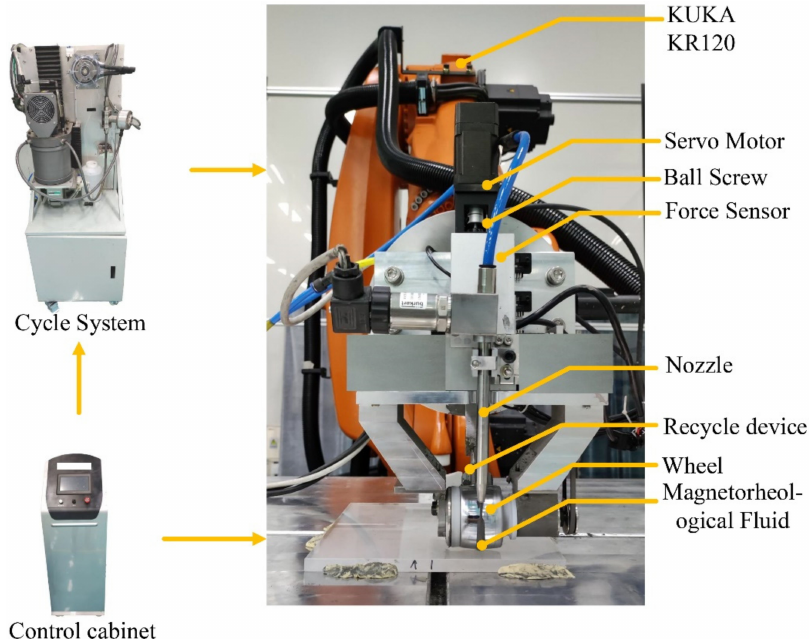
Figure 8. Robot magnetorheological polishing platform with constant force